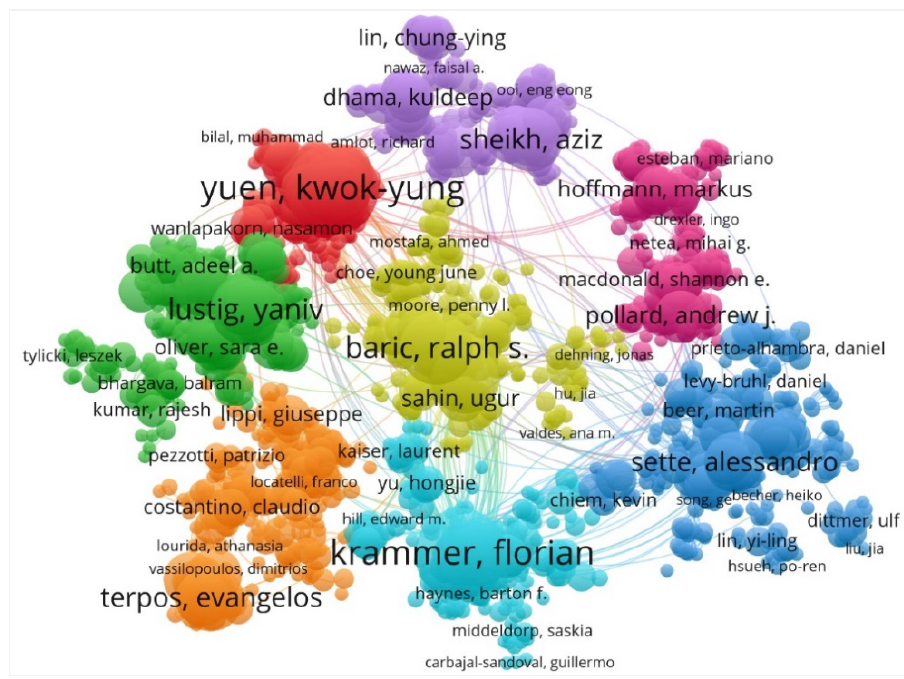
Figure 4. The authors’ co-authorship network visualization map in COVID-19 vaccine research. The authors’ co-authorship network visualization map was produced with VOSviewer, and the top 3300 authors who collaborated on at least four documents are shown in figure. The size of the nodes represents the number of documents, and authors with the same color in the view belong to the same clustered cooperation network.